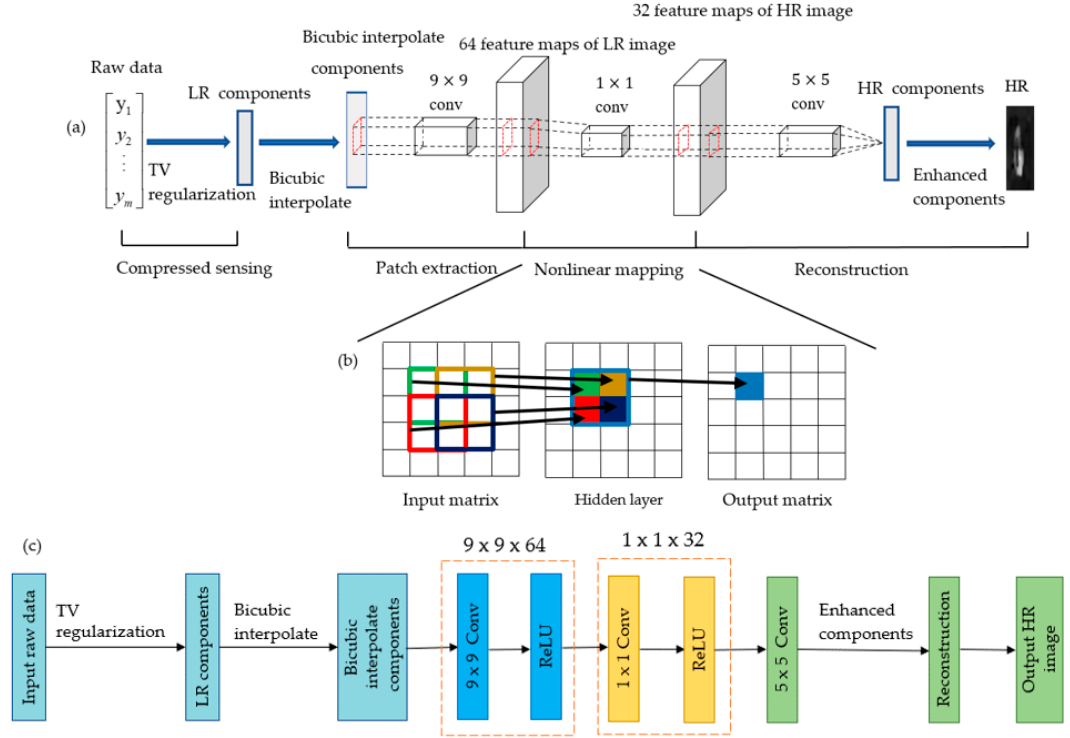
Figure 3. Architecture of the proposed reconstruction: ( a ) architecture of the proposed reconstruction; ( b ) convolved data from the input matrix to the output matrix, where the convolution process moves 1 step in the input matrix; and ( c ) a schematic diagram of our method.